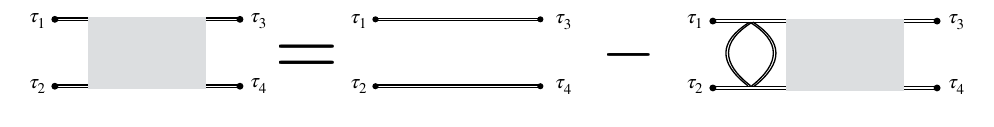
Figure 1 . Schwinger-Dyson equation for the exact propagator formulated in terms of Majorana fermions this is a four-point